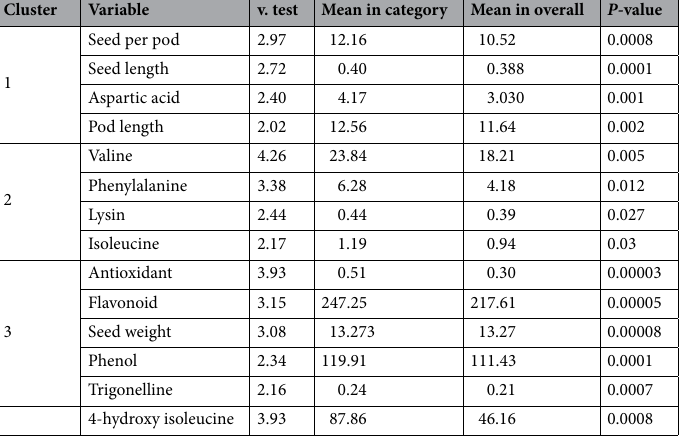
Cluster Variable v. test Mean in category Mean in overall P